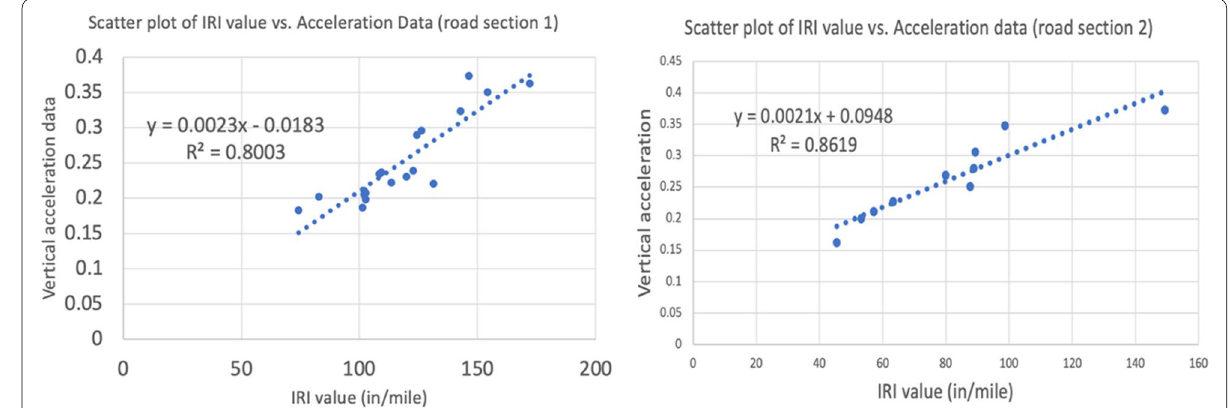
Fig. 7 Plots of IRI value and Selected